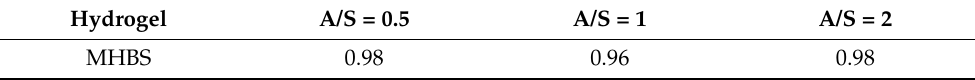
Table 1. Mean hydrogen bond strength (MHBS) of HPMC-g-poly(AM-co-SPA) hydrogels. Hydrogel A/S = 0.5 A/S = 1 A/S = 2 MHBS 0.98 0.96